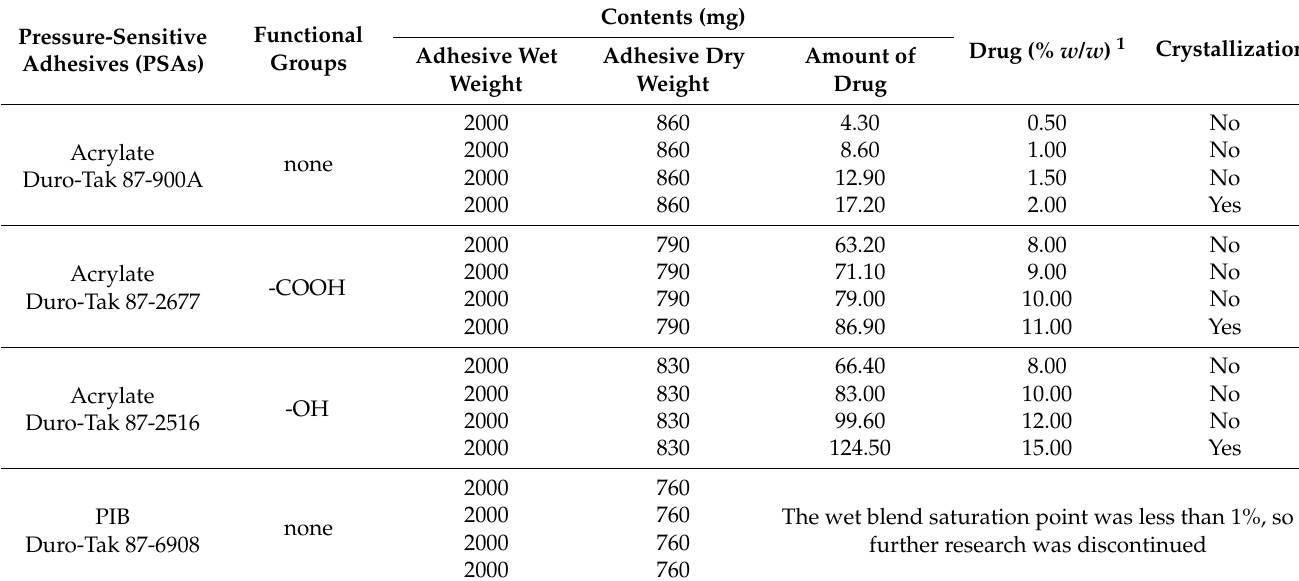
Table 1. Formulations prepared to determine the solubility of colchicine in various PSAs and the results of slide